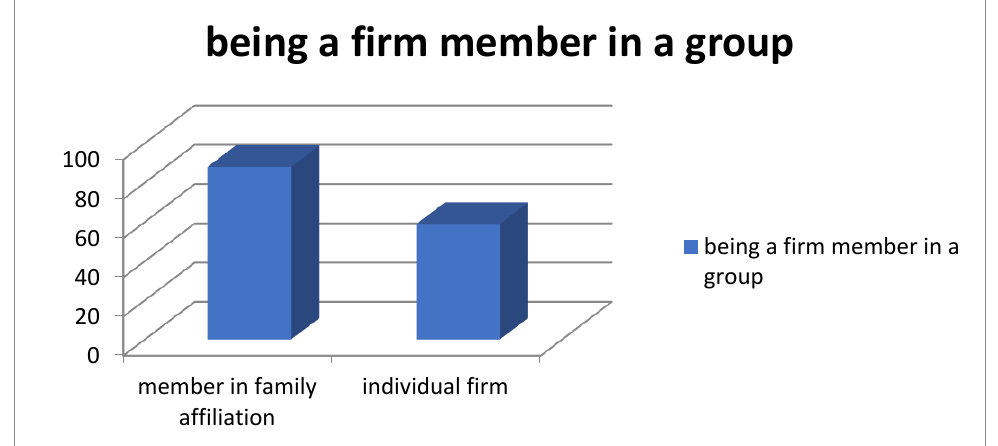
Figure 2. Distribution of Kuwaiti firms based on family-business affiliations.